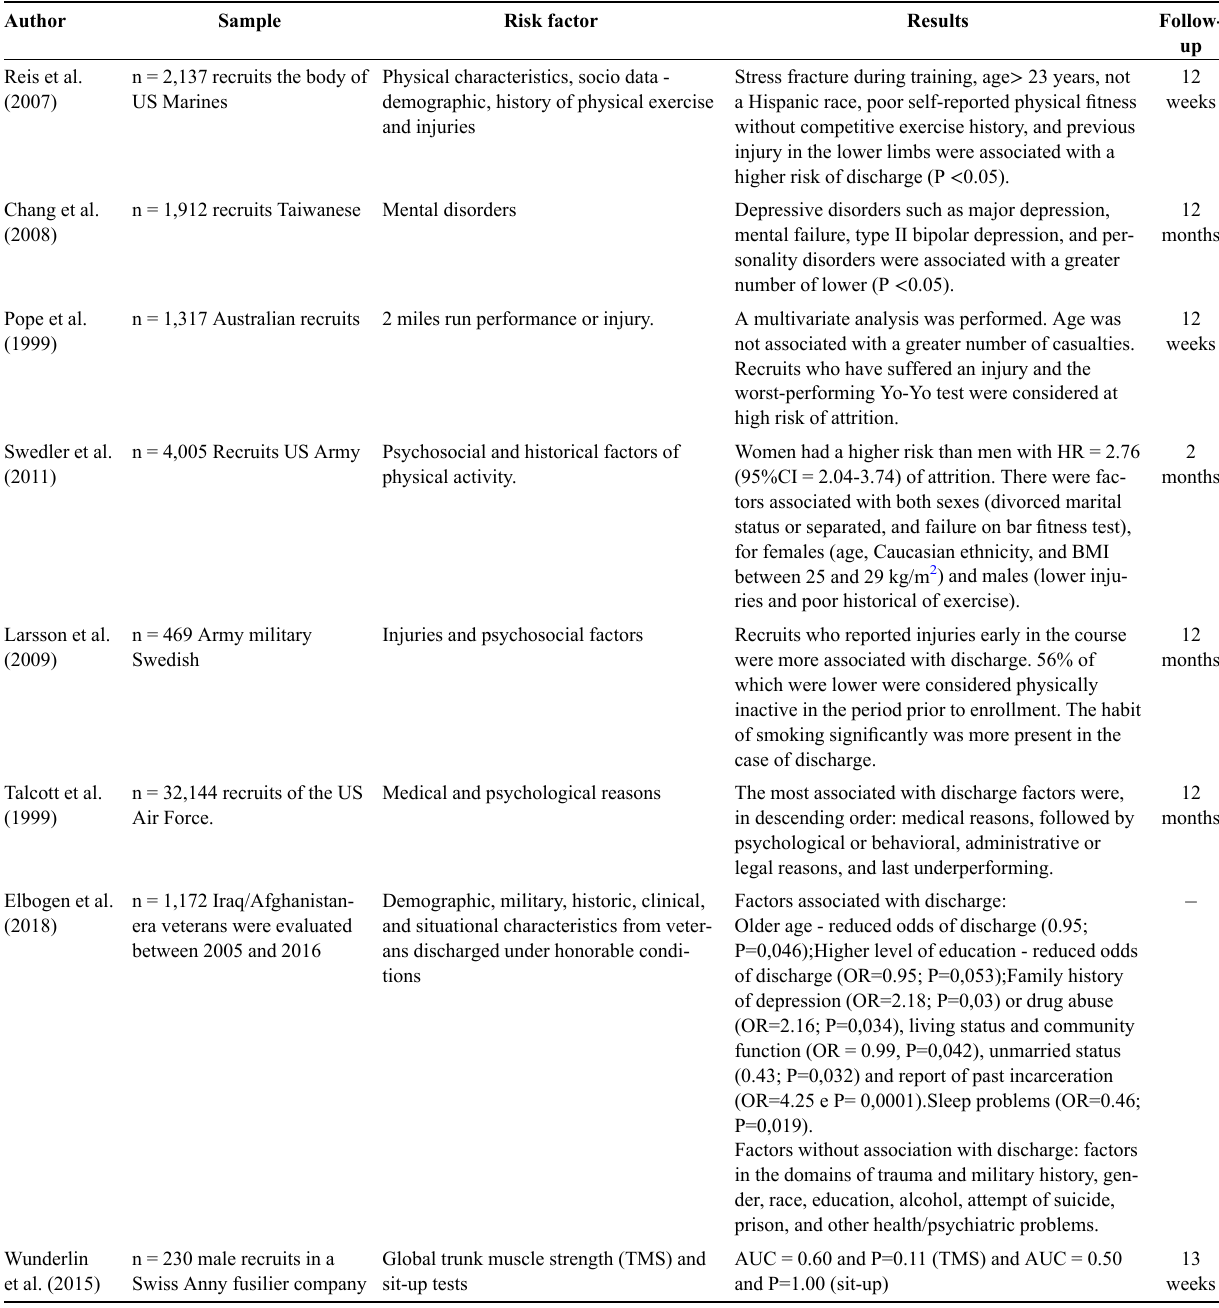
Table 2 - Characteristics of studies included in the systematic